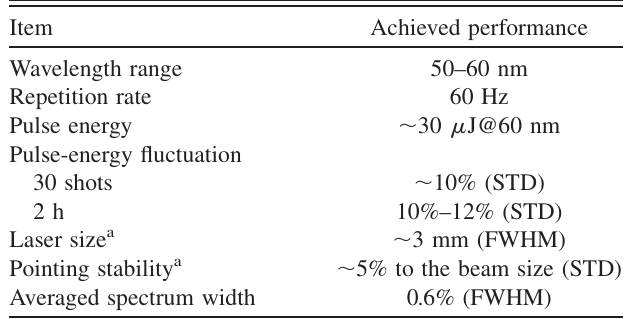
TABLE II. Achieved FEL performance at SASE saturation. Item